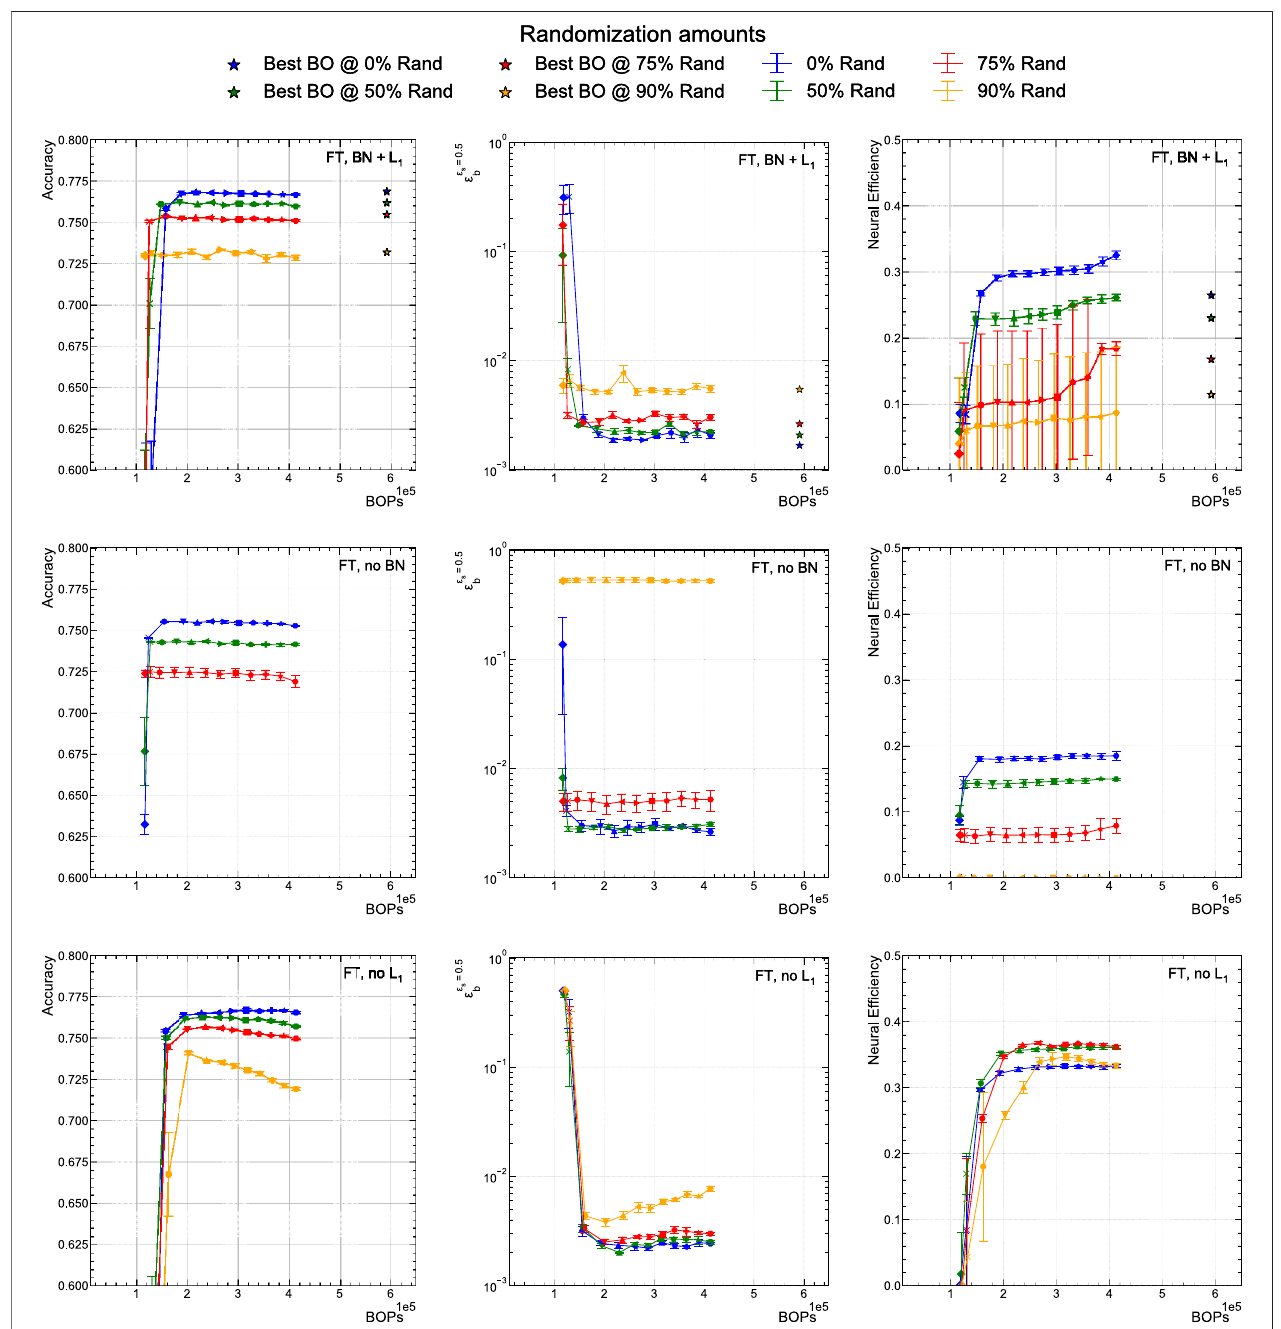
FIGURE 7| Comparison ofaccuracy, ϵ ϵ s (cid:2) 0 . 5 b , and neural ef fi ciency at 50% signal ef fi ciency for a 6-bit QAP model as BN layers and/or L 1 regularization is present in the model. L 1 + BN (upper) , no BN (middle) , and no L 1 (lower)